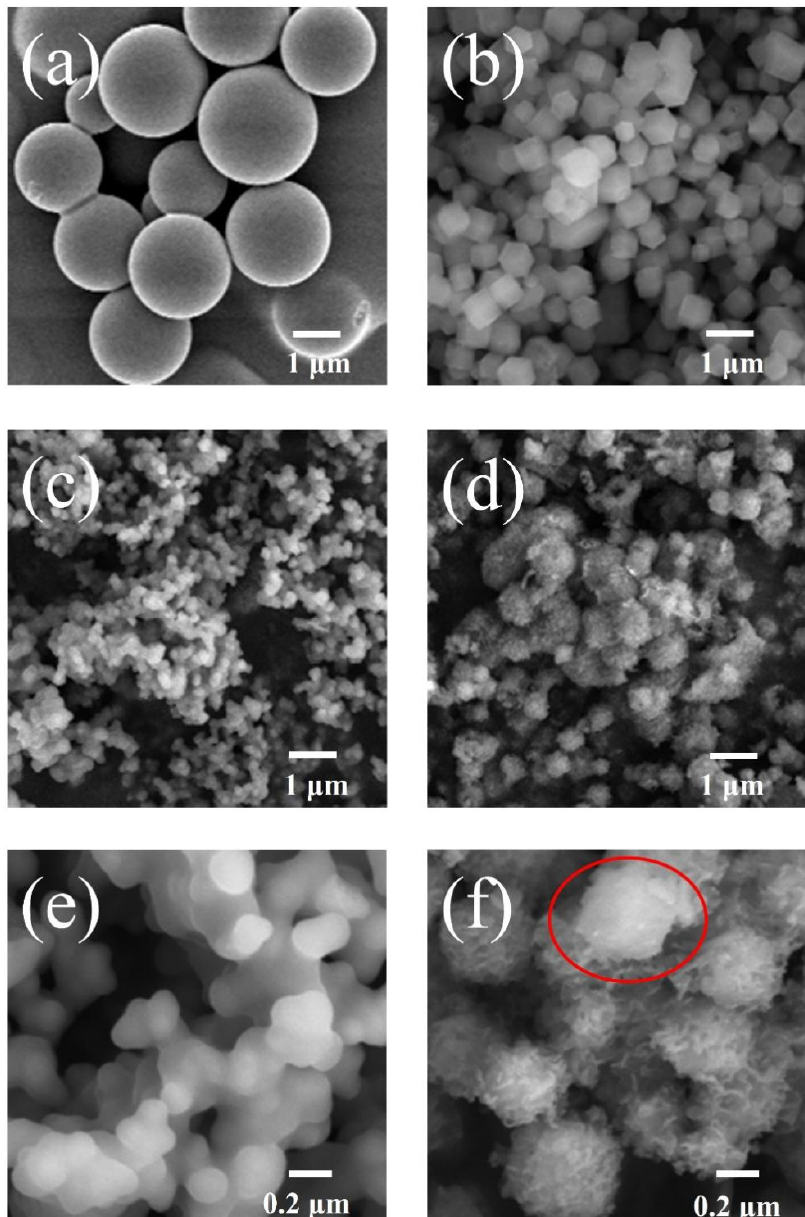
Figure 2. SEM images of the ( a ) carbon-hydrolysate, ( b ) Co-MOF (ZIF-67), ( c , e ) C1-ZIF-67 and ( d ) ( f ) C2-ZIF-67. ( d , f )